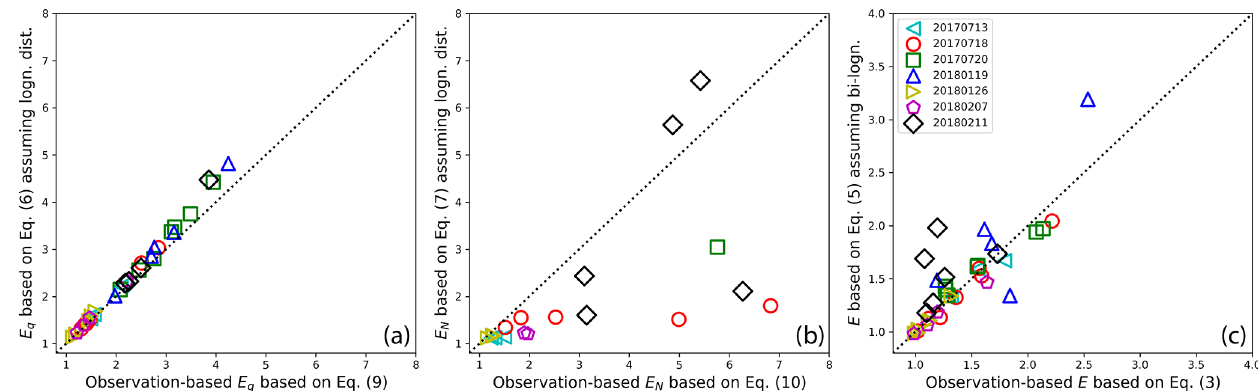
Figure 10. (a) A comparison of observation-based E q derived based on Eq. (9) and E q derived based on Eq. (6) assuming lognormal distribution for subgrid q c observations for all the selected hlegs. (b) A comparison of observation-based E N derived based on Eq. (10) and E N derived based on Eq. (7) assuming lognormal distribution or all the selected hlegs. (c) A comparison of observation-based E derived based on Eq. (3) and E derived based on Eq. (5) assuming bivariate lognormal distribution for the subgrid joint distribution of q c and N c